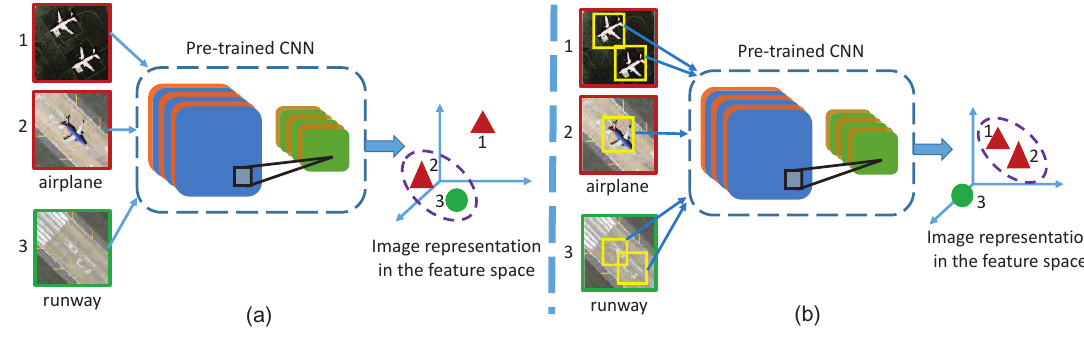
Figure 1. Remote sensing image representations by different deep CNN feature extraction frameworks: ( a ) existing deep CNN feature extraction from the whole image; ( b ) region-wise deep CNN feature